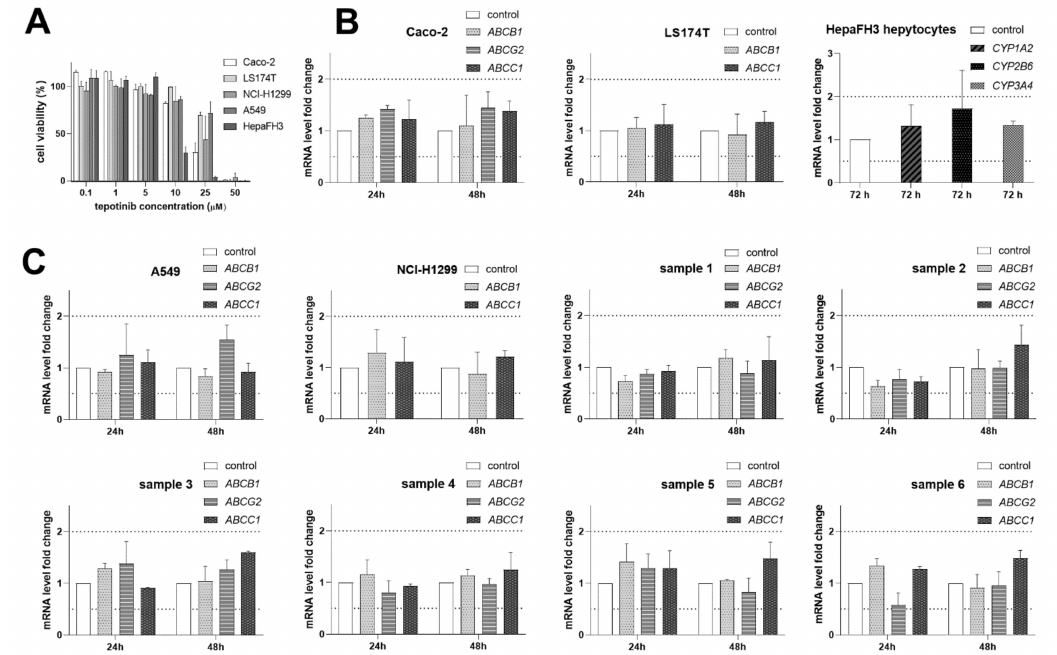
Figure 8. Gene induction studies with tepotinib. Treatments with vehicle-containing media and 40% DMSO in media were used as 100% and 0% viability controls for data normalization, respectively. ( A ) Effect of tested drug on the viability of ex- amined cell lines. ( B ) qRT-PCR analysis of expression of ABC transporters and CYPs following exposure to 1.5 µ M tepotinib in DIs-related models. ( C ) qRT-PCR analysis of expression of ABC transporters following exposure to 1.5 µ M tepotinib in NSCLC cell lines and ex vivo NSCLC primary cultures. Dotted lines define the boundaries of downregulation/upregulation positivity based on the European Medicines Agency (EMA) DIs guidelines